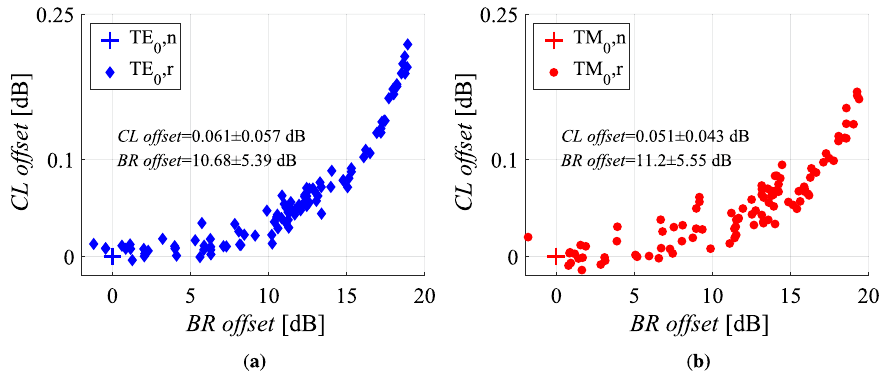
Figure 8. Scatter diagrams for the simulated offset of the coupling loss and the back-reflection metrics, when uniform random numbers in a restricted range are set to the varying geometrical and material parameters that define the quality of the transition. A variation of ± 20 nm from the nominal value is assumed for the geometrical variables and a change of ± 0.02 is accounted for the refractive indices of the materials. Nominal values are set to all the other parameters, as described in Table 1 for the flat interface case. Both TE and TM polarisations are studied. The wavelength is set at 1310 nm . The indices n and r refer to the nominal and the random cases,